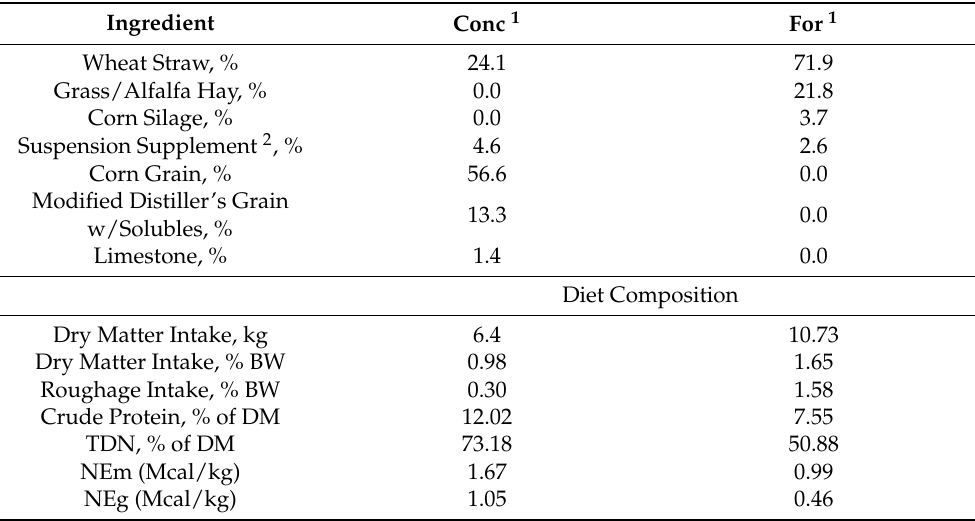
Table 1. Dietary components (dry matter basis) consumed by cows receiving a forage-based (For) or concentrate-based (Conc) diet during mid- and late-gestation. Ingredient Conc 1 For 1 Wheat Straw, % 24.1 71.9 Grass/Alfalfa Hay,